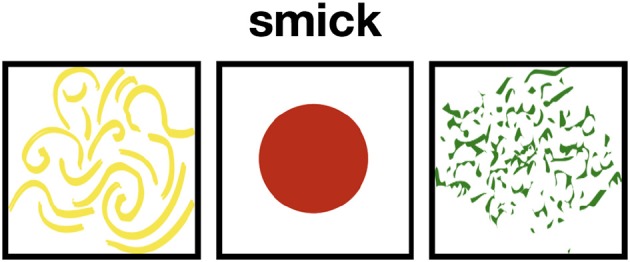
Example of a trial.